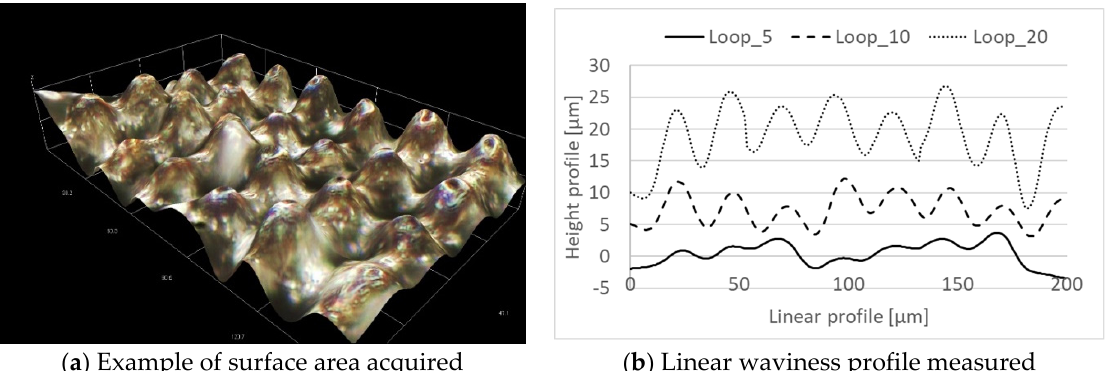
Figure 11. Profile analysis for the third experimental series. ( a ) Example of surface area acquired; ( b ) Linear waviness profile measured.